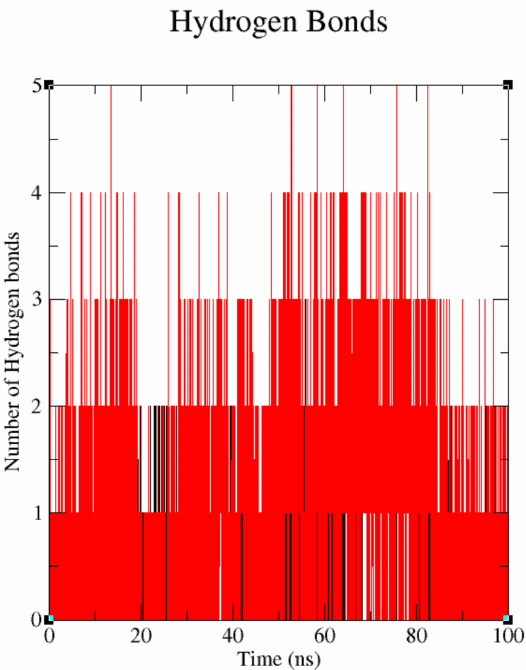
Figure 7. Hydrogen bond interaction of fenoxaprop-p-ethyl (black) and sinigrin (red) with ACCase over 100 ns